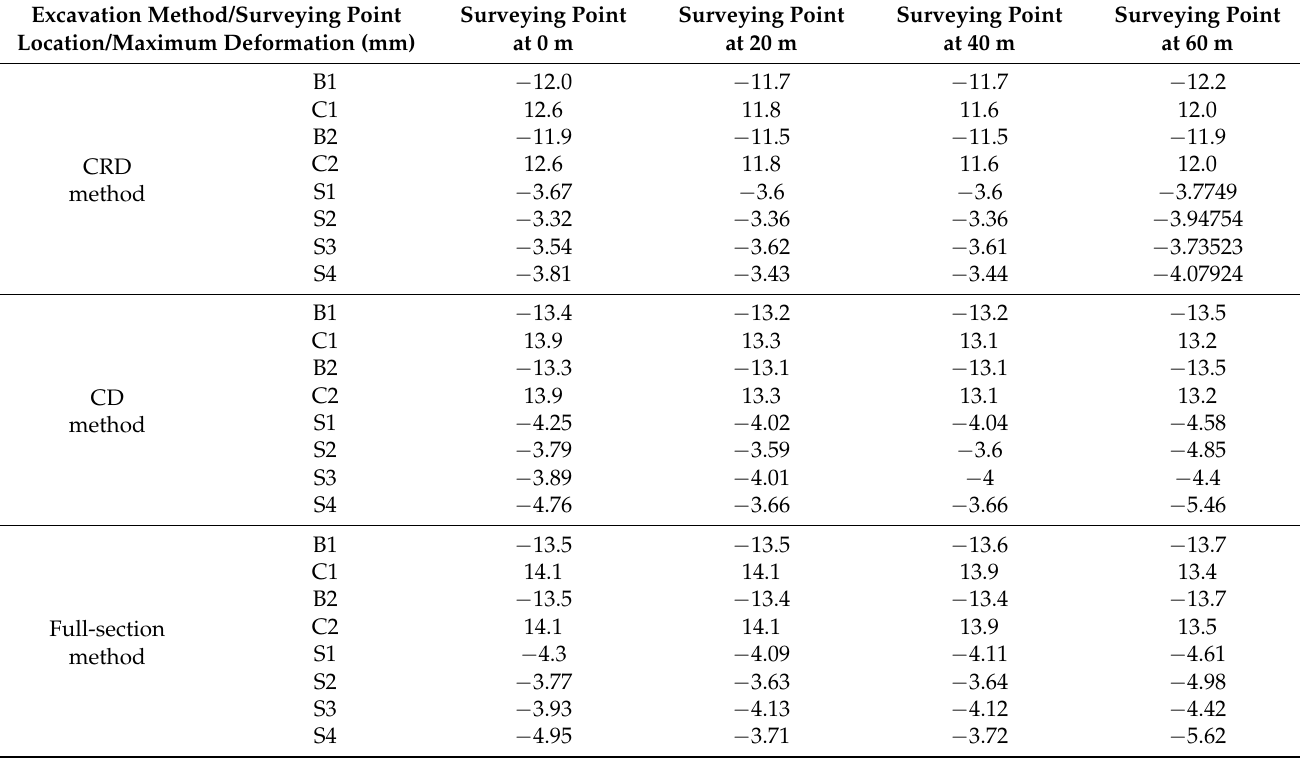
Table 3. Maximum deformation value of surveying points in different excavation